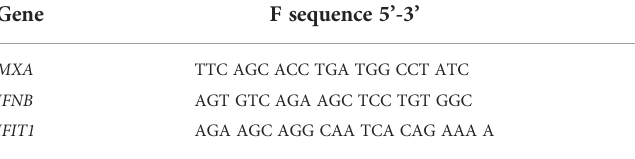
TABLE 1 SYBR green primer